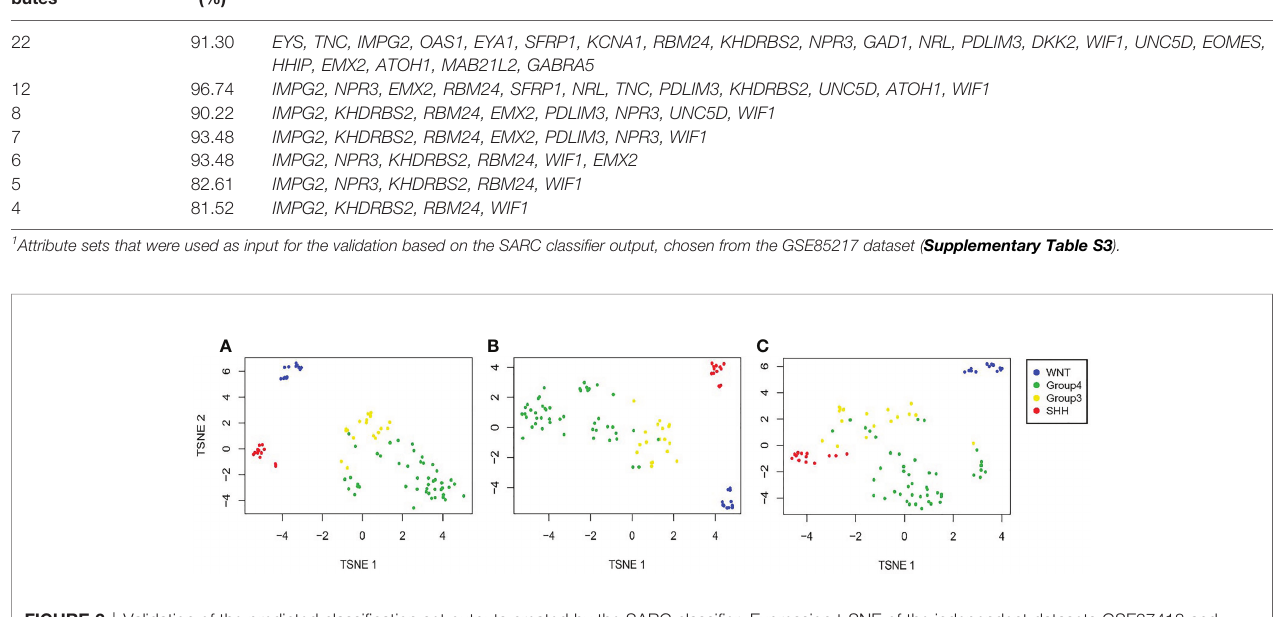
TABLE 3 | Classi fi cation accuracy of the reduced genes sets (12 genes or fewer), as compared with the full, 22-gene NanoString set, used on the independent validation datasets GSE37418 and GSE41842 (n = 92 MB samples altogether). Number of attri- butes